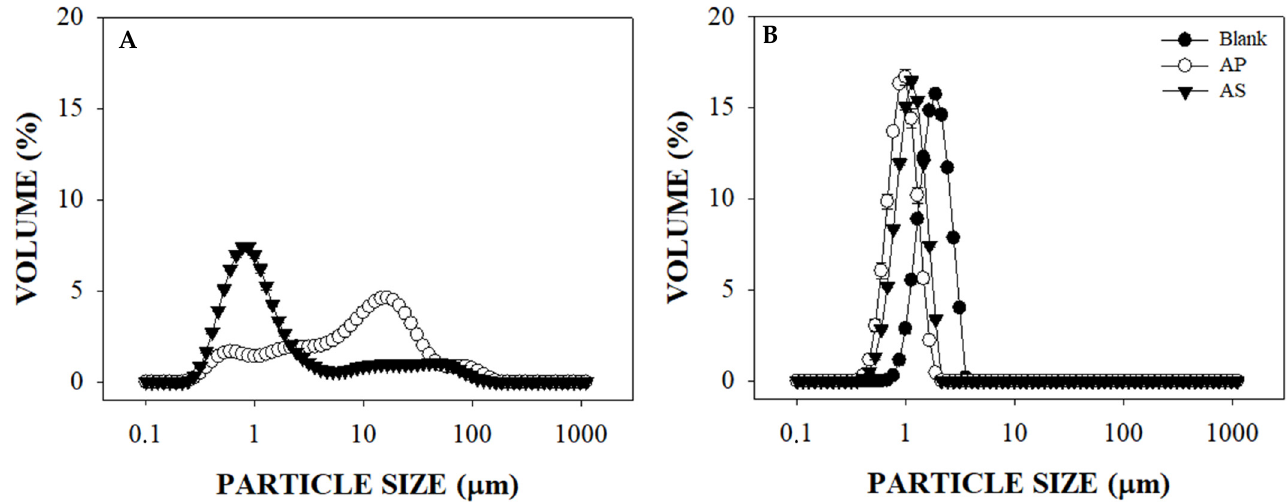
Figure 1. Effect of peel and seed extracts on the particle size distributions of oil-in-water (O/W) dispersions (without surfactant) and emulsions using low methoxyl pectin (LMP) as surfactant. ( A ) = O/W dispersions without LMP formed with avocado seed (AS) or avocado peel (AP) extracts; ( B ) = Emulsions containing LMP without or with AS or AP.